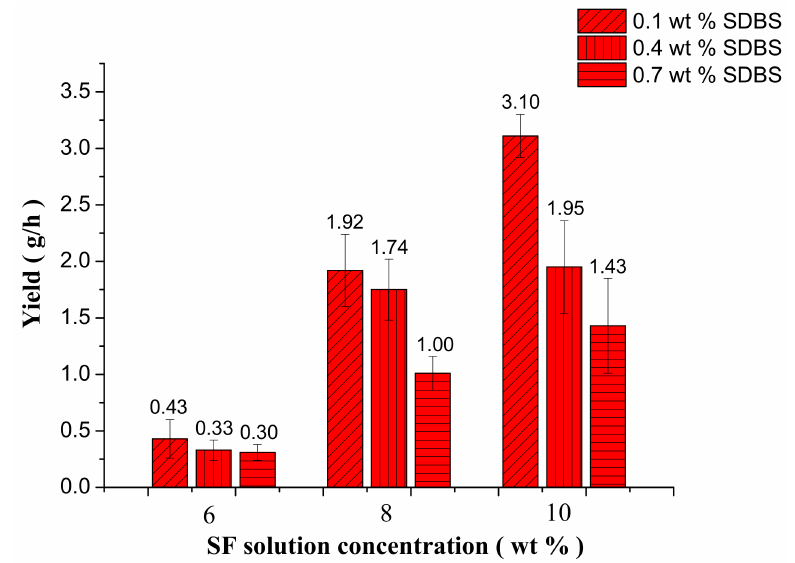
Figure 13. Yield of the SF nanofibers with the different SF concentrations and SDBS contents when the gas flow volume was 50 m 3